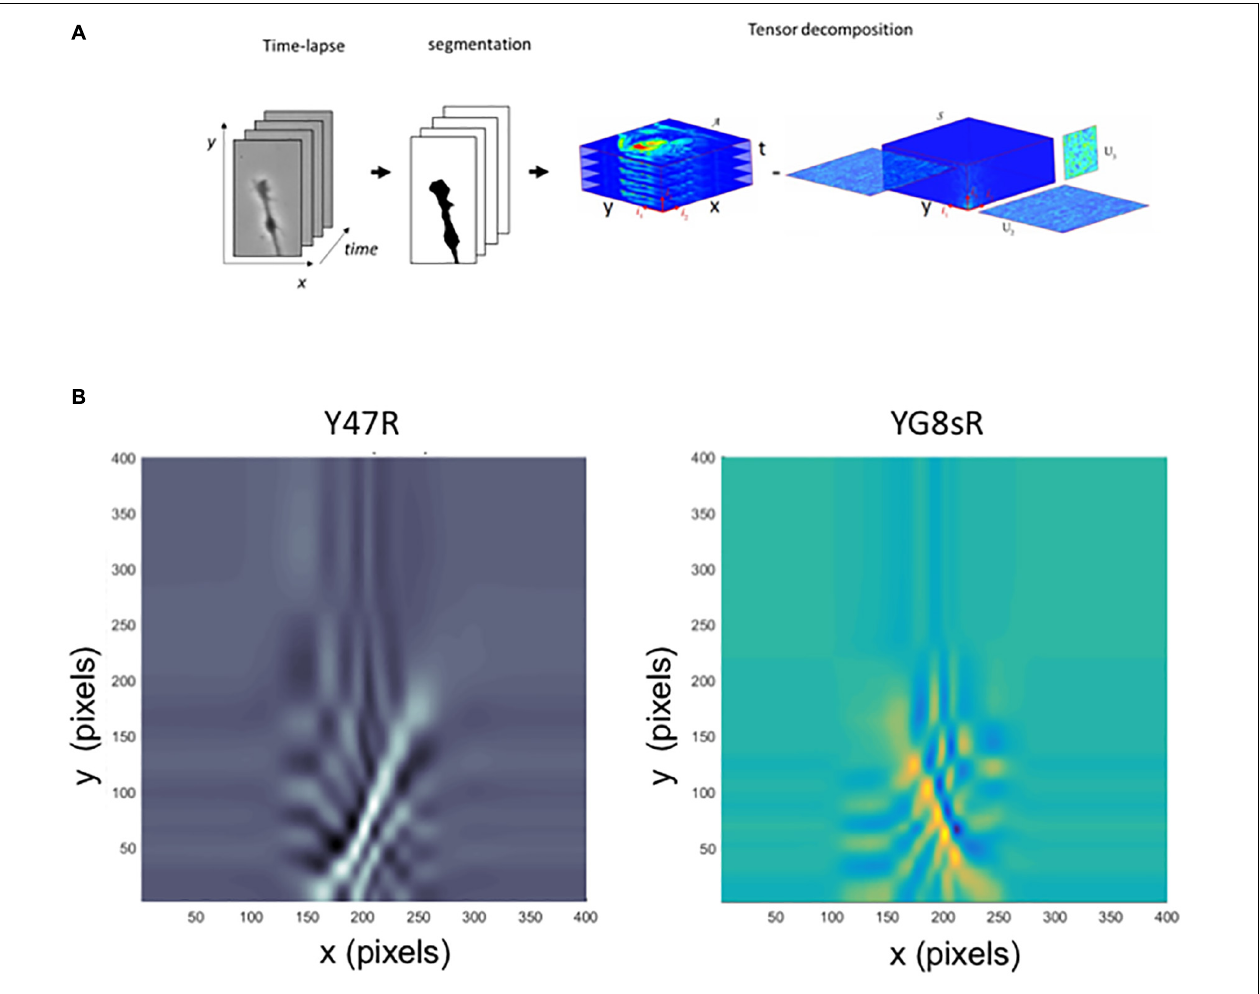
FIGURE 4 | A tensor analysis confirms the reduced dynamics of DRG neurons’ growth cone morphology from the YG8sR mouse. (A) Visualization of the methodology applied for the tensor analysis. (B) Graph of the two principal components obtained for tensor analysis. Like the PCA analysis, the principal components indicate the main patterns of movement of all points that form the growth cone, including the axonal segment built during the time-lapse. These patterns are seen in the graphs as continuous lines that stand out from the background color. The lines start in the lower central part of the images (initial position of the cones at t = 0) and are directed to the right, left or above in the images with different angles (final position of the cones at t = 60 min). When the main components of the YG8sR mouse (right) and the control are compared (left), we observed that movement patterns of the growth cones of the YG8sR mouse (yellow and blue) are different from those of the control, presenting shorter movement patterns directed to the right or left